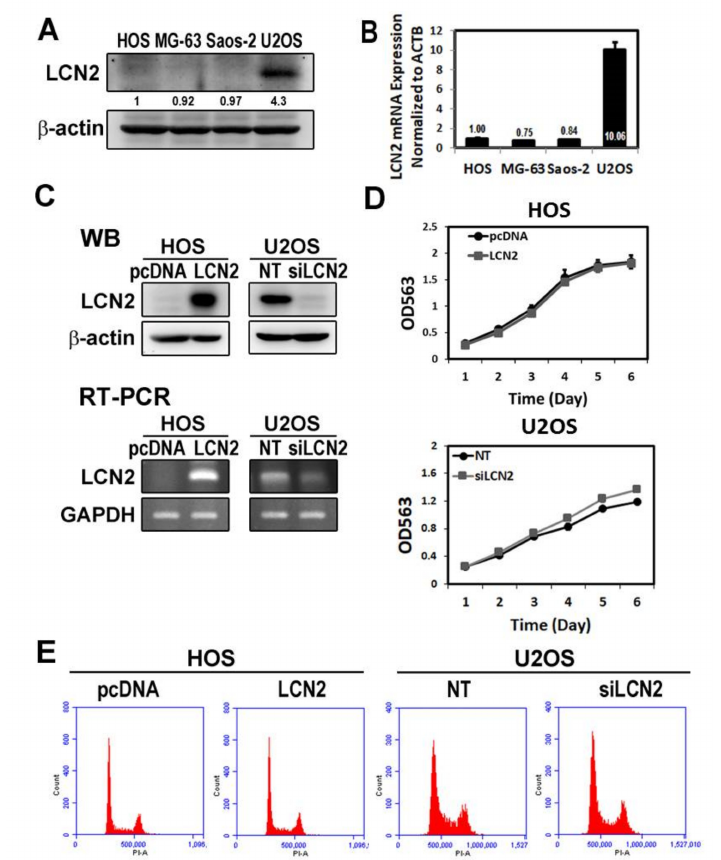
Figure 1. Effects of LCN2 on cell viability of human osteosarcoma cells. ( A ) Using Western blot analysis and ( B ) RT–PCR, the LCN2 protein and mRNA expressions in human osteosarcoma HOS, MG-63, Saos-2, and U2OS cells were detected, respectively. ( C ) Western blot analysis and RT–PCR for LCN2 protein and mRNA expressions of HOS cells after transfection with vectors containing a constitutively active LCN2 cDNA and U2OS cells after siRNA directly against the LCN2 expression were conducted. ( D ) Using an MTT assay, cell viability of HOS cells after transfection with vectors containing a constitutively active LCN2 cDNA and U2OS cells after siRNA directly against the LCN2 expression was detected up to 6 days and the effects are illustrated after quantitative analysis. ( E ) HOS cells after transfection with vectors containing a constitutively active LCN2, cDNA, and U2OS cells after siRNA directly against the LCN2 expression were subjected to flow cytometry after PI staining to analyze the cell cycle